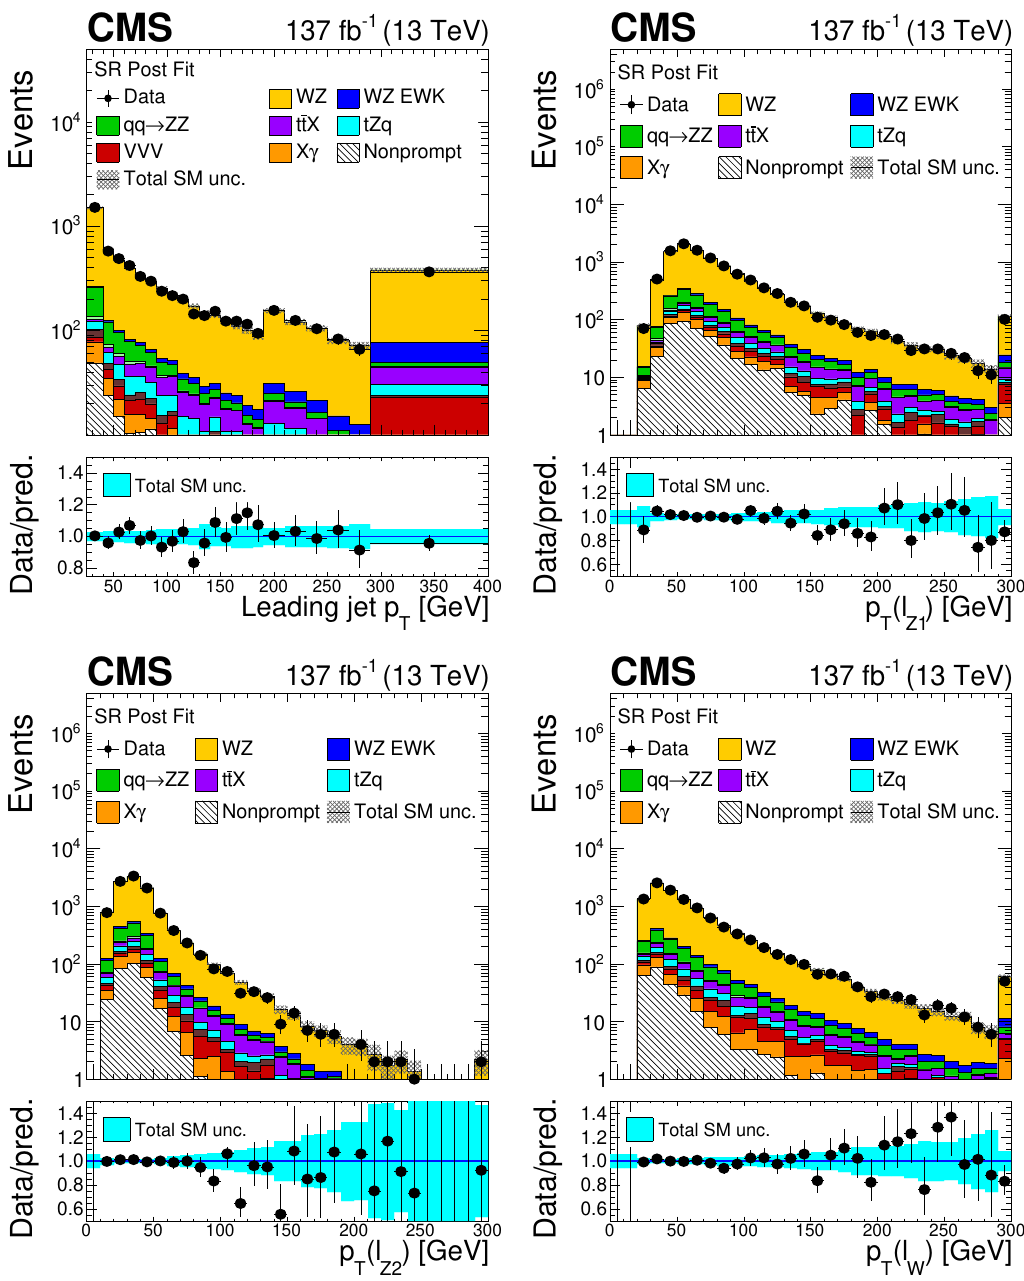
of the leading jet with no p T lepton (top right), transverse momentum of the ‘ Z1 lepton (bottom W